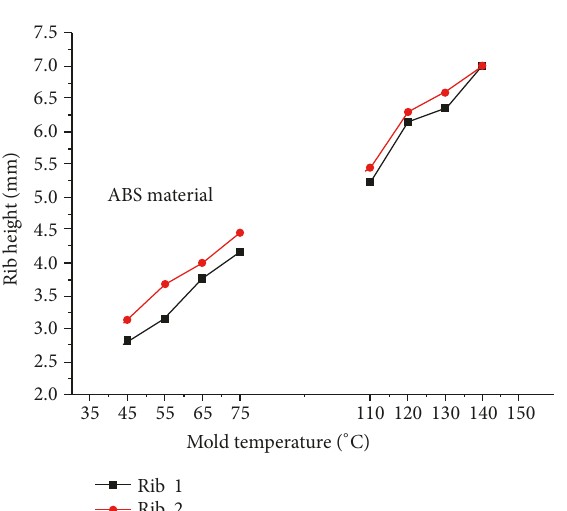
Figure 22: Improvement of thin rib height at different cavity